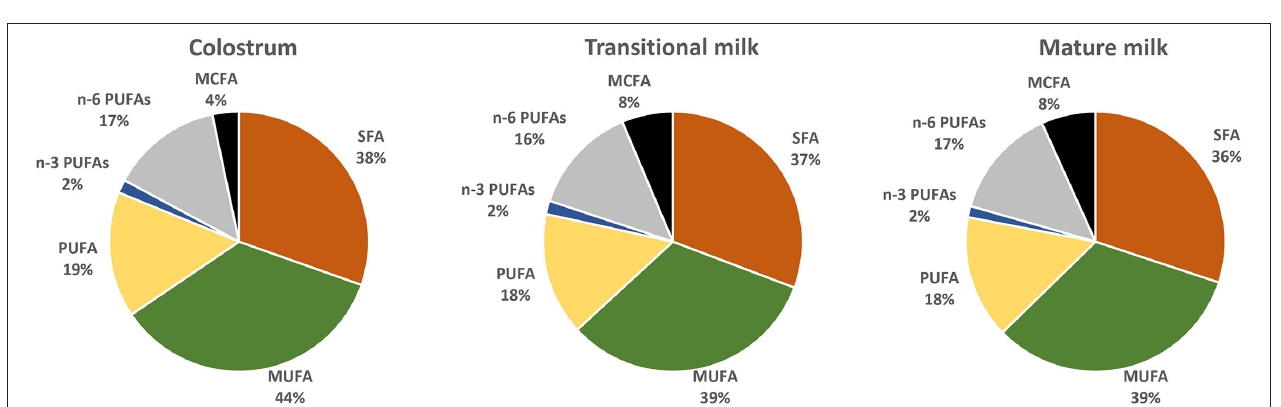
FIGURE 5 | Distribution of phospholipid classes in colostrum (C), transitional milk (TM) and mature milk (MM) in different geographical cohorts. Data from (23), Denmark; ( 86), Malaysia; (13), Spain (Madrid, Valencia and Murcia); (84), Spain (Granada); (58), China (Beijing and Suzhou); (85), UAE (Sharjah, Dubai, and Ajman). PE, phosphatidylethanolamine; PI, phosphatidylinositol; PS, phosphatidylserine; PC, phosphatidylcholine; SM, sphingomyelin.